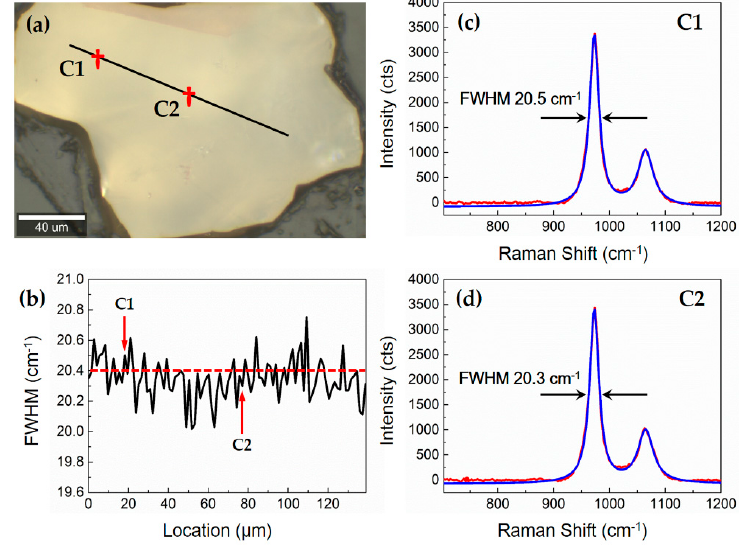
Figure 3. ( a ) The image of monazite chip (shown in Figure 2b) with black line and red crosses marked. ( b ) The variation of FWHM of a Raman band at 972 cm − 1 along the black line in ( a ). The FWHMs of a Raman band at different sites were around 20.4 cm -1 ,which is indicated by the red dash line. ( c , d ) Two Raman spectra (red spectrogram) from the cross-site (C1, C2) acquired by line scanning along the black line and fitted Raman spectra (blue spectrogram) with Lorentz function.